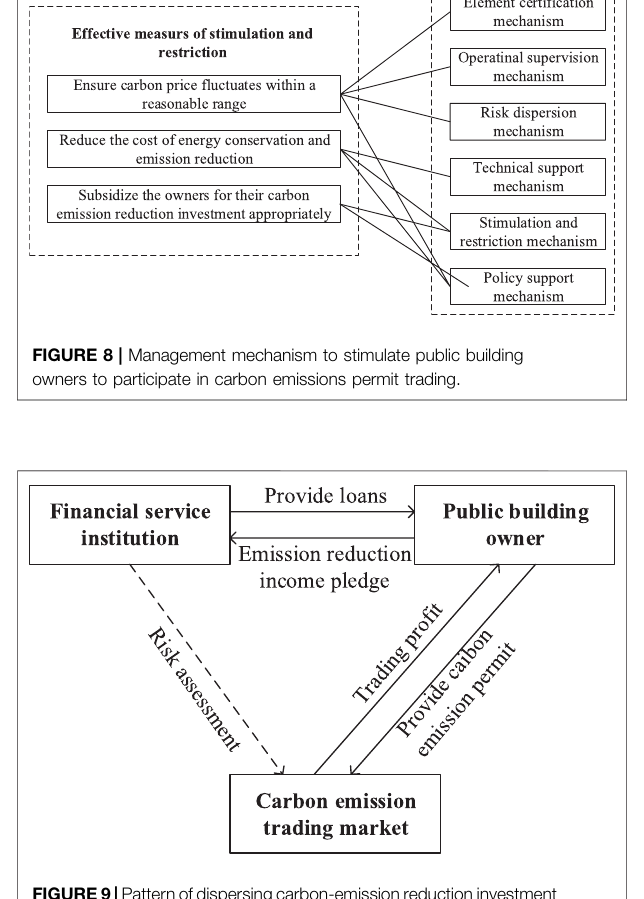
Frontiers in Energy Research |